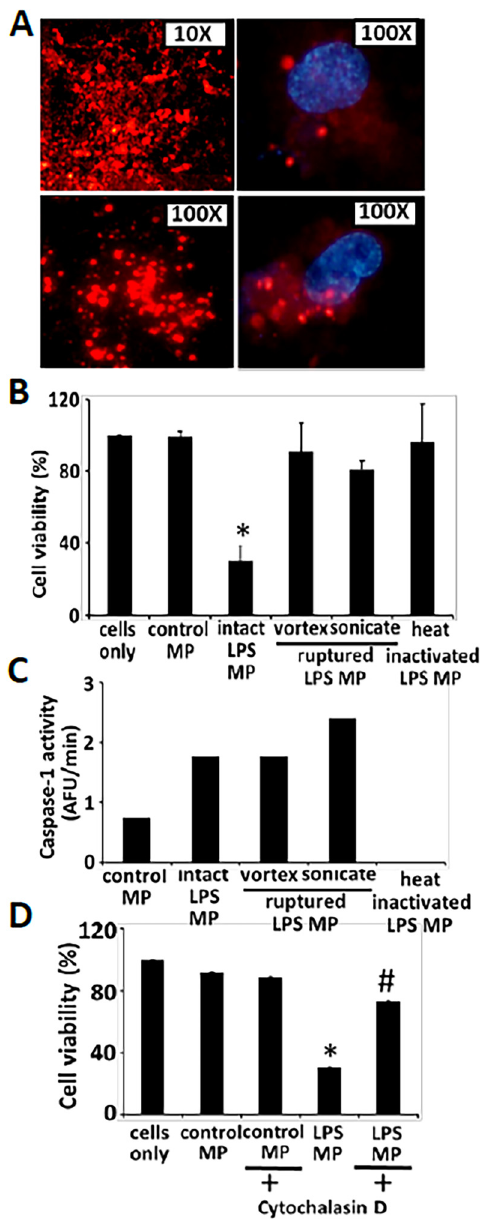
Fig 4. Encapsulation is necessary for exogenous caspase-1 mediated apoptosis. THP1 cells were first labeled with phospholipid dye, DiLC16 for 30 min, washed, stimulated with LPS (1 μ g/ml) for 2h and microparticles were isolated. A) Labeled microparticles were observed under fluorescence microscope; left panel (top and bottom). Uptake of labeled microparticles by DAPI stained HPMVEC was observed by fluorescence microscopy (right panel: control MP (top) and LPS MP (bottom)). B) Microparticles were then either kept intact or disrupted by vortexing or by sonication, or subjected to heat inactivation. Microparticles were then applied to HPMVECs and endothelial cell viability was analyzed by MTS assay (n = 3). * intact LPS MP vs control MP or intact LPS MP vs ruptured/ heat inactivated LPS MPs. C) Caspase-1 activity of each fraction was measured using WEHD enzymatic assay from two experiments. Mild homogenization of microparticles or sonication did not affect caspase-1 activity in contrast to heat inactivation. D) HPMVEC were pretreated with cytochalasin D (5 μ g/ml) for 30 min, washed two times to remove trace of reagent and then control or LPS MP was subjected to cells as previously described. Uptake of microparticles and effect on apoptosis of HPMVEC was analyzed by MTS assay (n = 3 experiments) * intact LPS MP vs control MP; # LPS MP with cytochalasin D vs LPS MP.